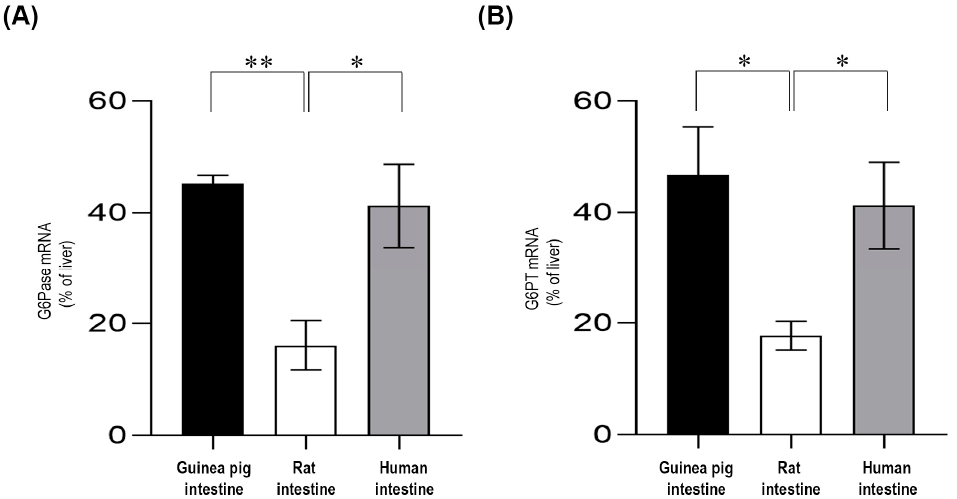
Figure 3. Real-time PCR analysis for the glucose-6-phosphatase ( A ) and glucose-6-phosphate transporter ( B ) mRNA expression levels. Each assay was run in triplicate, and negative controls were included; n = 3 for all species. The expression levels of intestinal mRNAs were expressed relative to the liver, which was considered 100%. Bars display mean ± SEM, and statistical analysis was performed using a one-way ANOVA with a Tukey post hoc test with p = 0.0–0.01 * and p = 0.01–0.001